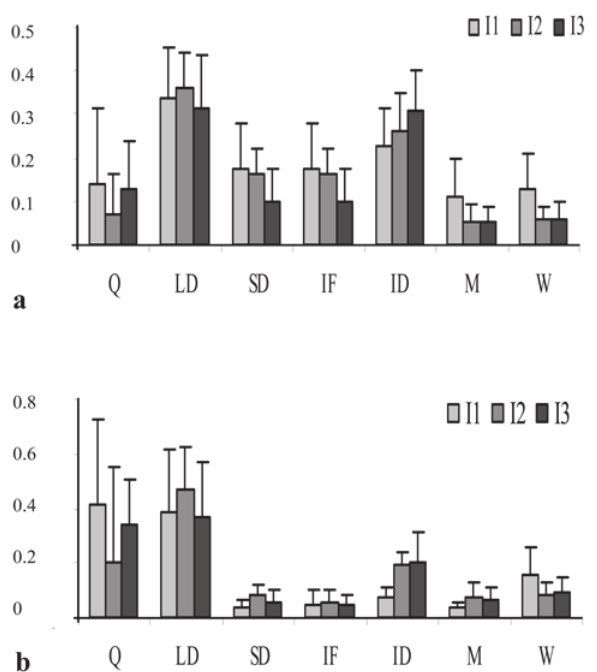
Fig. 5. Relative frequency (a) and time (b) of behavioral units of males in Austrolebias reicherti at 10-min time intervals. I1: first interval; I2: second interval; I3: third interval.